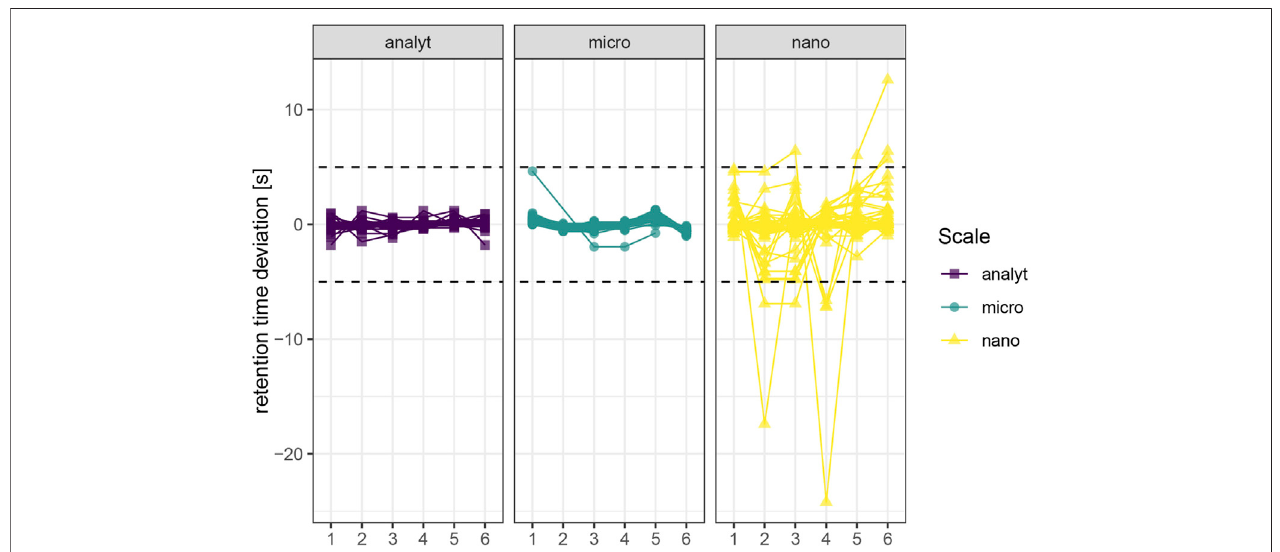
FIGURE 3 | Retention time stability. A quality control sample (c = 1 μ g/L) was injceted six times ( n = 6) spanning 8.5 h (analytical), 9 h (micro) and 15 h (nano). Replicates 4 – 6 were injected right after another. The dashed line marks 5 s deviation from the mean retention time. Molecules with distorted peak shapes also display reduced retention time stability due to imprecise automatic detection of the peak apex.